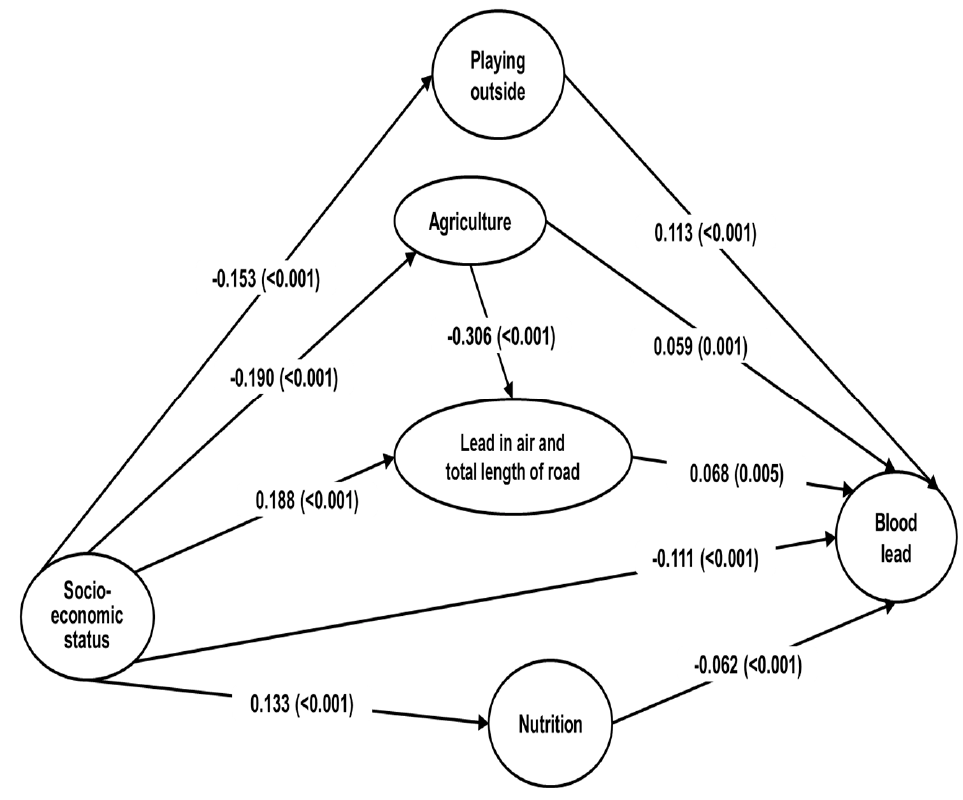
Figure 2. Pathways of lead exposure in a sample of Korean children defined using structural equation analysis. Footnote: all beta coefficients are standard estimates and the numbers in parentheses are p -values.